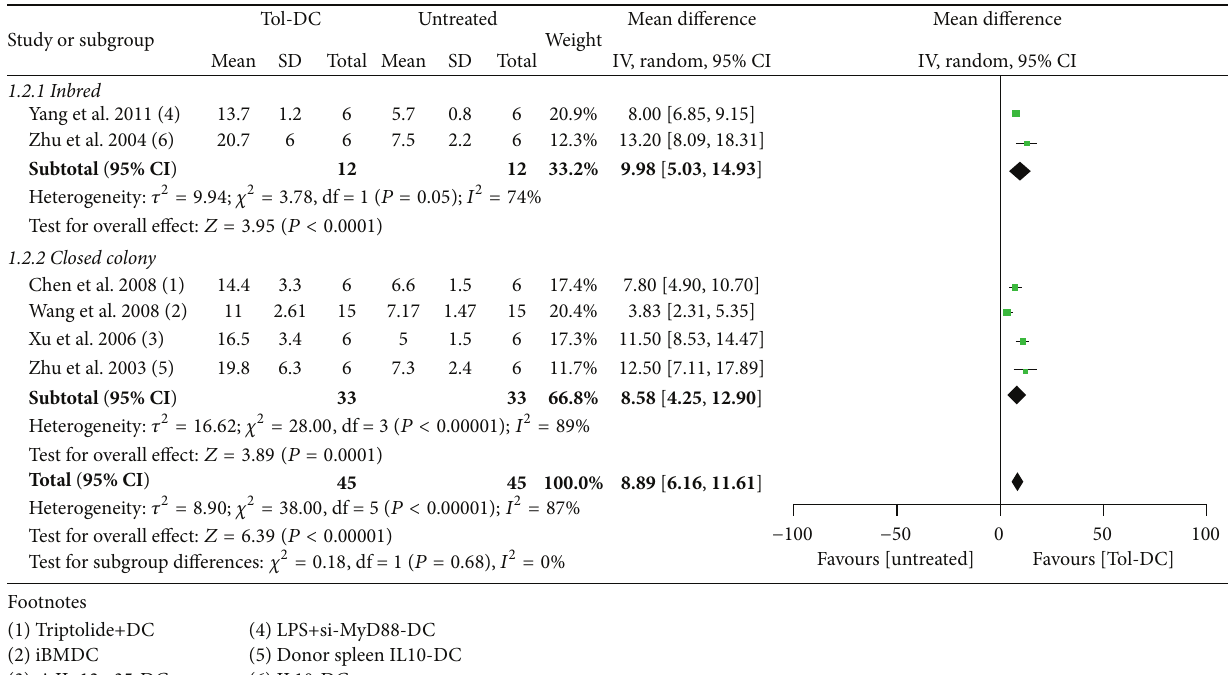
Figure 6: Mean difference (95% confidence intervals) for subgroups of inbred and closed colony rats for allografts survival in liver (a), renal (b), and small intestine (c) transplantation models. All mice and rats in other models are inbred.